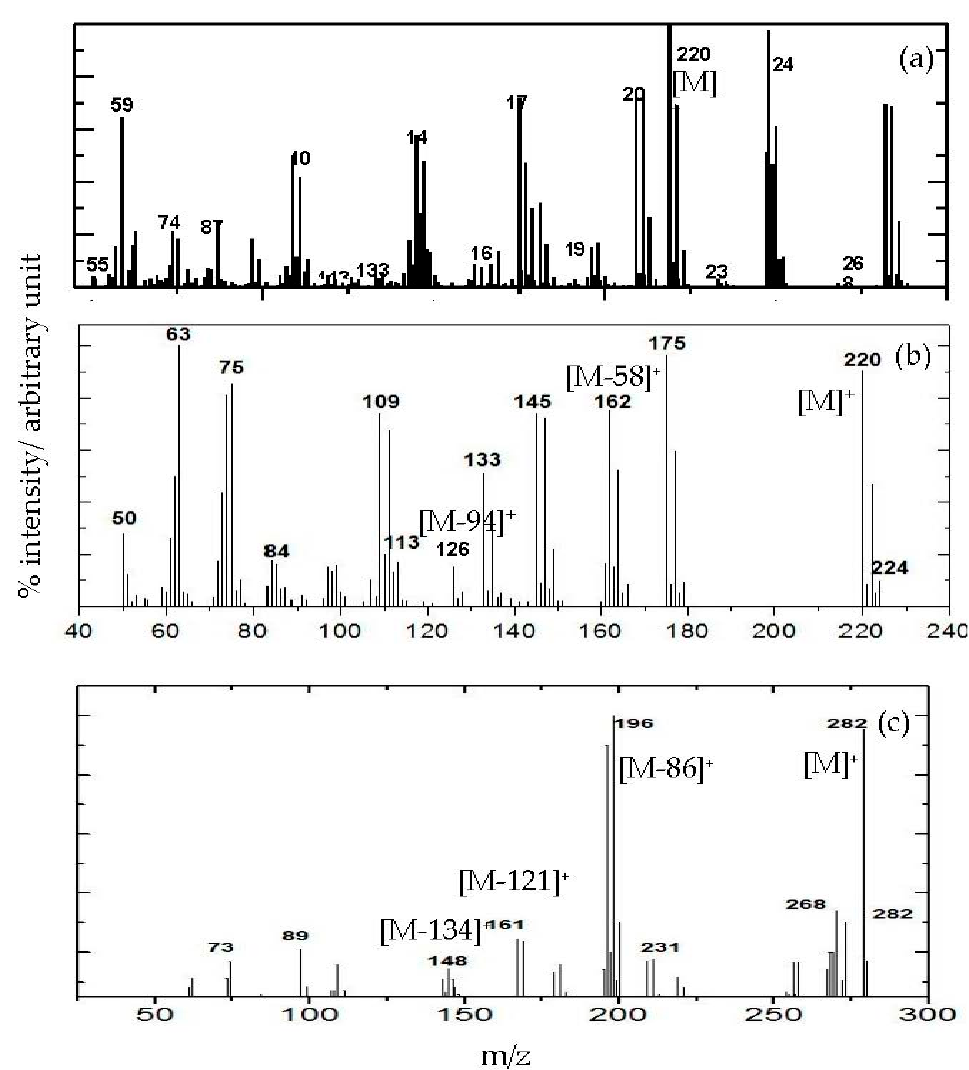
Figure 4. DIMS pattern of dual guest nanocomposite ( a ) TBA, ( b ) 3,4D and ( c )